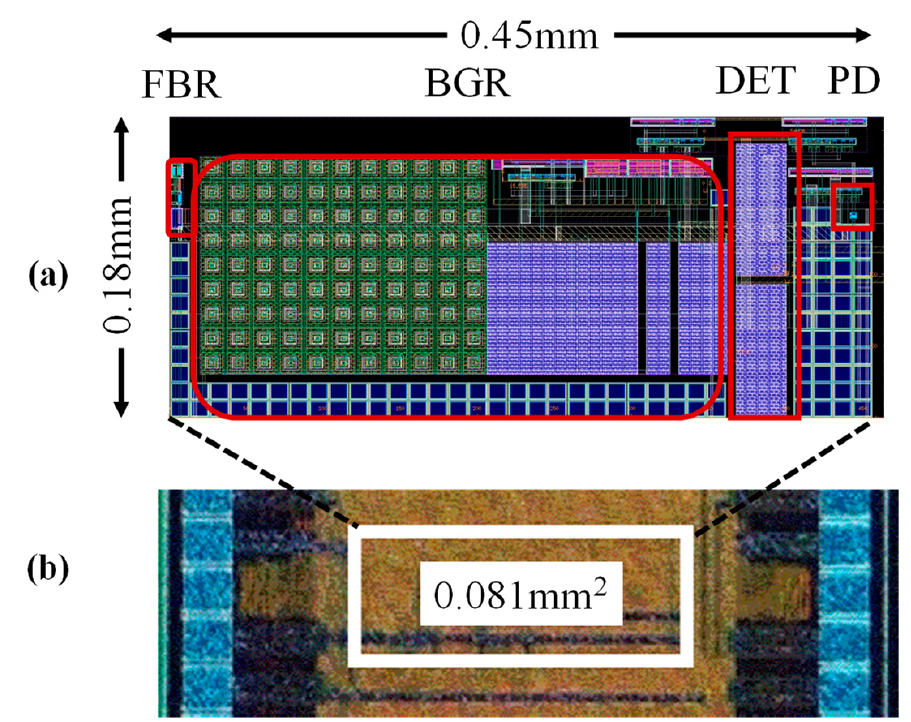
Figure 8. ( a ) Layout of the AC-DC converter and ( b ) a die photo. Figure 9a shows I DD vs. V DD by varying the load resistance R L . The AC-DC converter regulates V DD at 1 V with 10 µ A or below. Figure 9b shows the measured waveform at different temperatures. The voltage source starts at 0.1 s with an amplitude of 10 V at 100 Hz. The converter charges up the load capacitance C VDD for 0.25 s until V DD reaches about 1 V. The measured average and ripple of V DD are summarized in Table 2. meas. SPICE